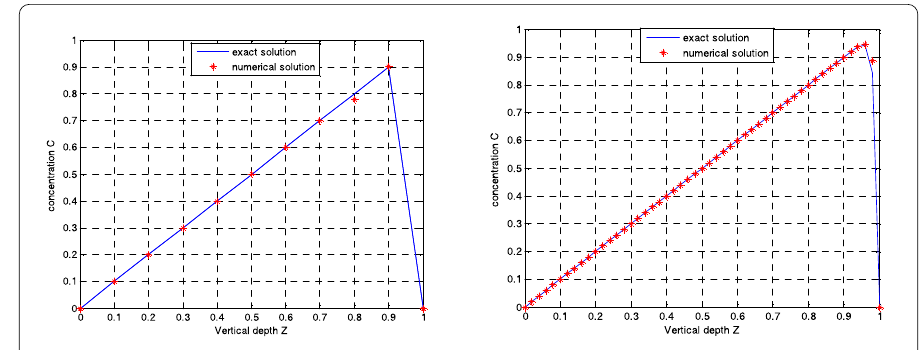
Figure 4 Comparison between exact solutions and UFPM numerical solutions when the node number is 11 (left) and 51 (right) at scale = 3